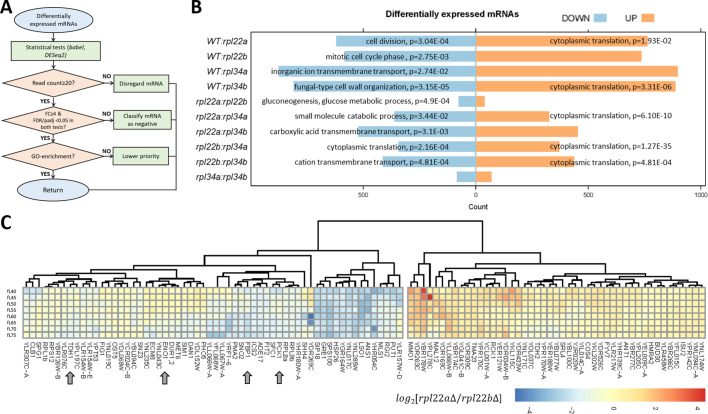
Transcripts with altered relative abundance in rpl22 and rpl34 paralog deletion mutants.(A) Decision diagram for identifying transcripts that were differentially expressed in paralog deletion mutants. (B) The number of transcripts with significantly different levels (adjusted p-value/FDR < 0.05, Log2FC ≥ 2, identified both from the babel and DESeq2 R language packages) at any one cell size pool, between any pairwise comparison between WT, rpl22, and rpl34 mutants is shown. The data for wild type diploid cells were from Blank et al., 2017. The Gene Ontology terms (The Gene Ontology Consortium, 2019) that were most enriched in each case are shown, based on the PANTHER (Mi et al., 2019) platform classification, incorporating the Holm-Bonferroni correction. All the gene names of loci with significant changes in transcript levels are in Figure 4—source data 1 (sheet ‘cumulative’). The ‘UP’ and ‘DOWN’ groupings correspond to each pairwise comparison shown, with the ‘UP’, or ‘DOWN’, group higher, or lower, for the strain in the numerator of the ratio, respectively. (C) Reduced levels of transcripts encoding glycolytic/gluconeogenic enzymes in rpl22aΔ compared to rpl22bΔ cells. The Log2-transformed ratio of the corresponding TPM values is shown in each case, across the different cell size pools. The data were hierarchically clustered without supervision and displayed with the pheatmap R package. Each row corresponds to a separate 5 fL cell size interval, from 40 to 75 fL, from top to bottom. The arrows indicate transcripts for key enzymes of glycolysis and gluconeogenesis. mRNAs with missing values across the cell sizes we analyzed were not included in the heatmap.Figure 4—source data 1.mRNAs with significantly different abundances between any two strains.